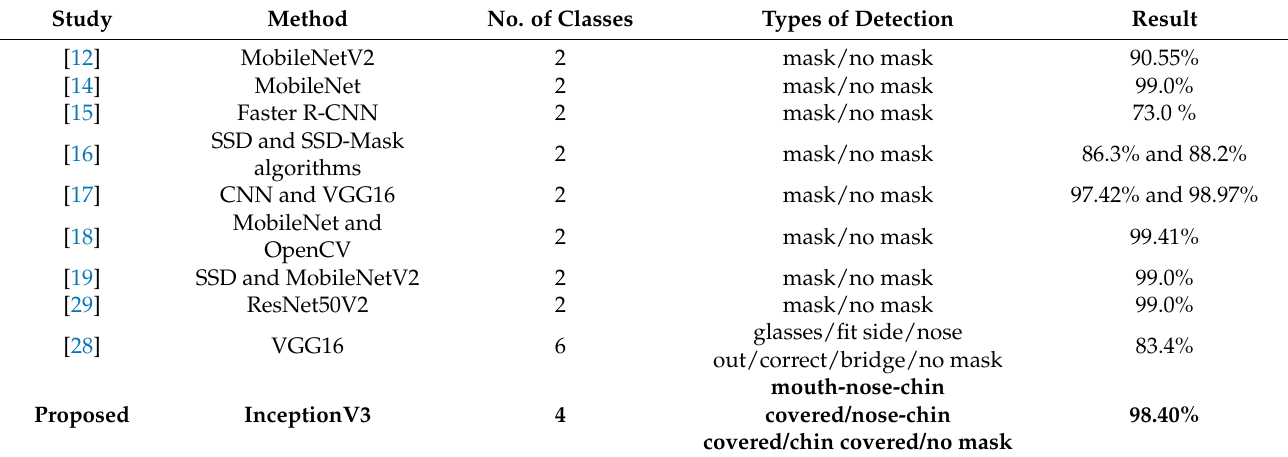
Table 6. Comparative analyses of the proposed scheme with prior studies.